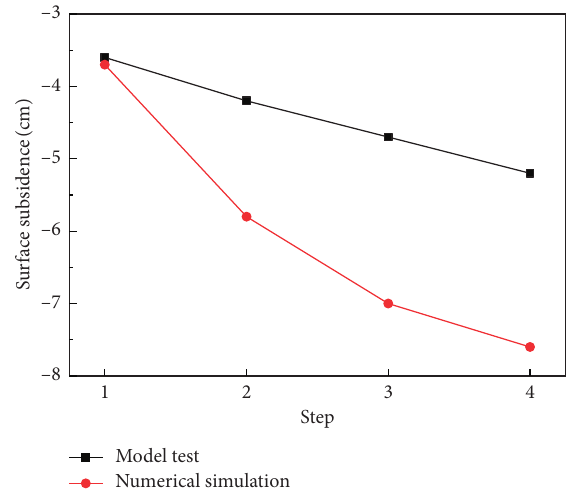
Figure 18: Comparison of maximum surface subsidence in working condition 1.